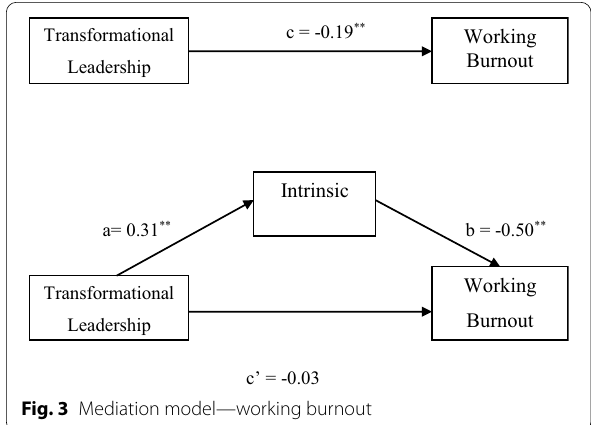
Fig. 3 Mediation model—working